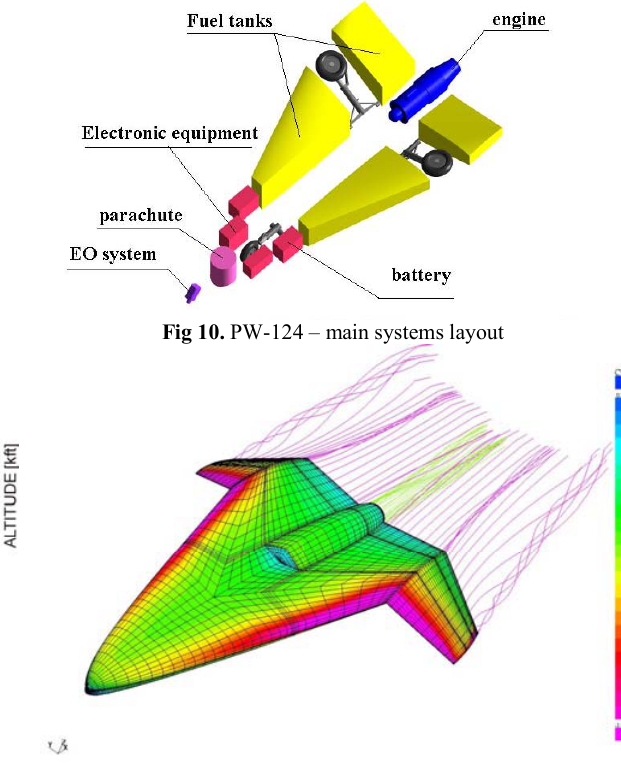
Fig 11. 1 PW-124 aircraft – 6200 panels, 28 patches NACA 65 -012 airfoils in the outer wings were 1